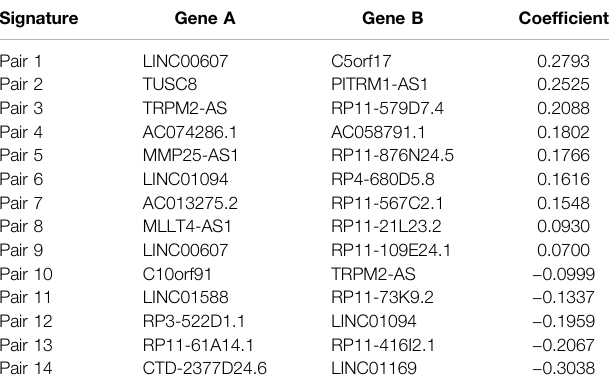
TABLE 1 | List of gene pairs and corresponding coef fi